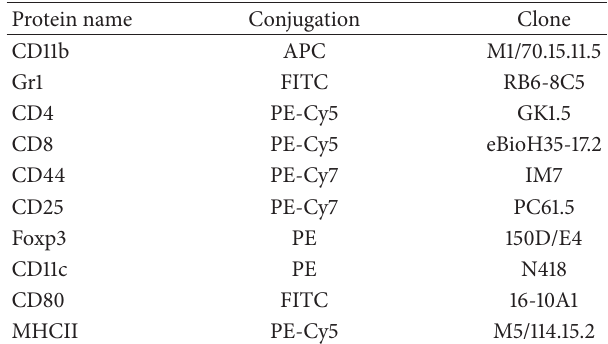
Table 2: List of the antibodies used in flow cytometry for immune cells